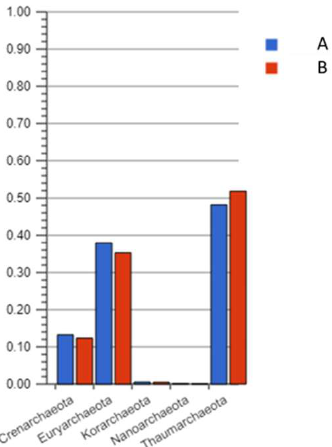
Figure 7. Archaeal profile of the samples in A (non-polluted), B (polluted) soil.